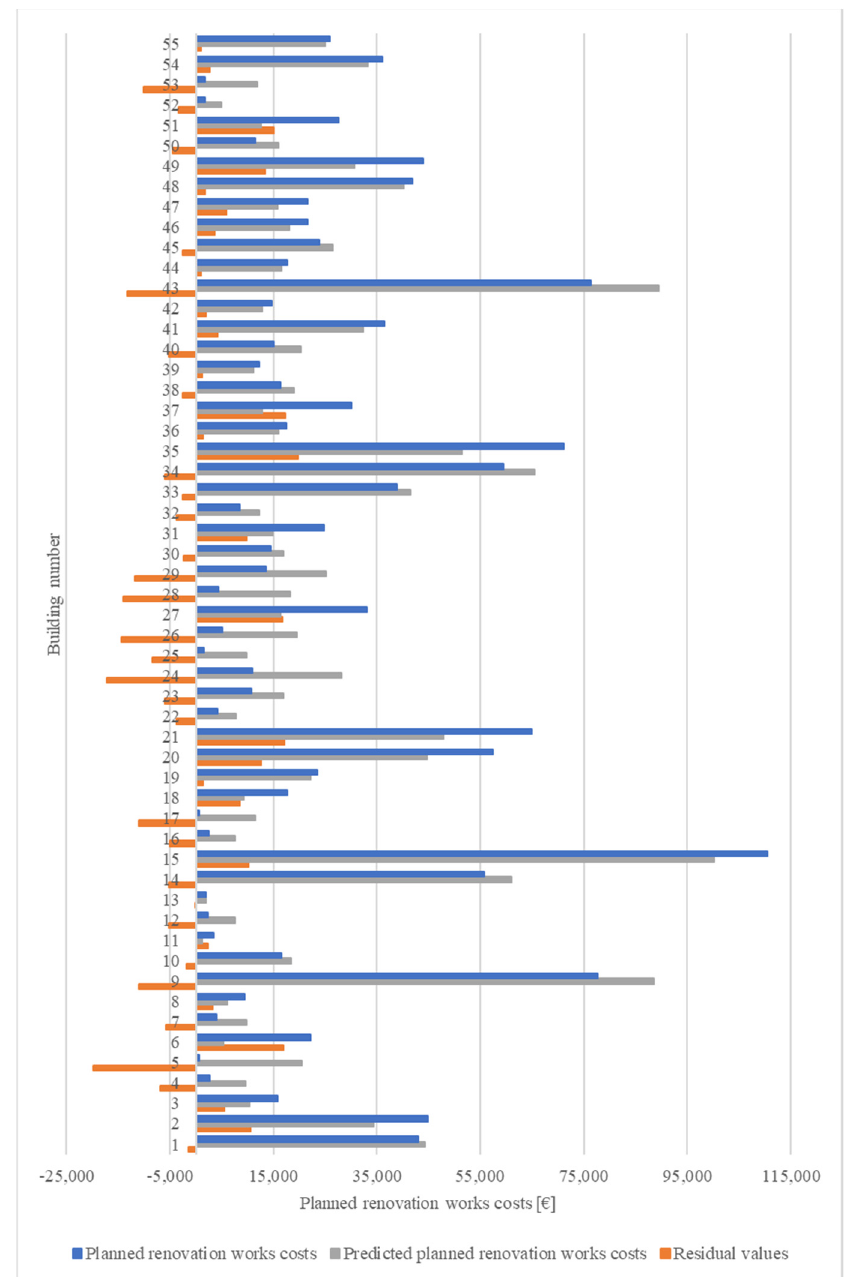
Figure 7. Multiple linear regression results: planned costs, predicted costs, and residual values.